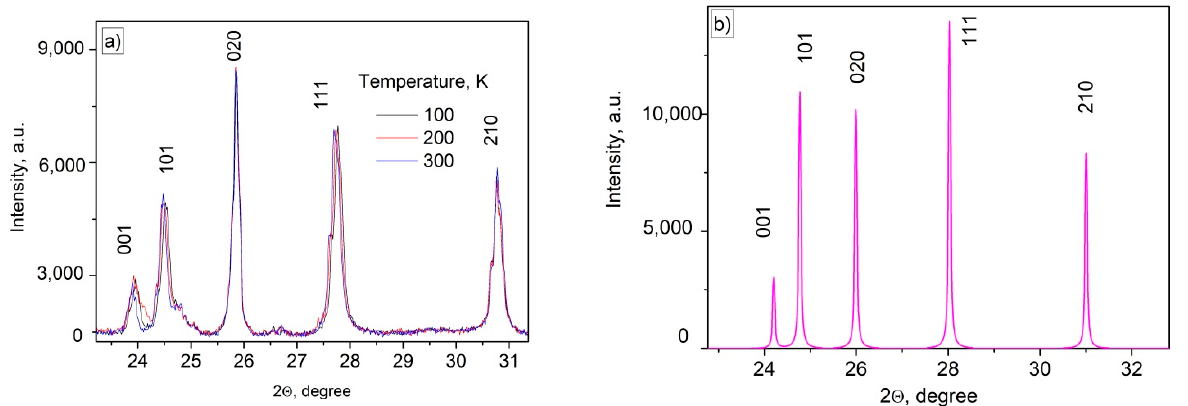
Figure 2. Experimental XRD patterns ( a ) of Nd 3+ (0.5%), Yb 3+ (1.0%):YF 3 sample and XRD simulation of YF 3 ( b ).